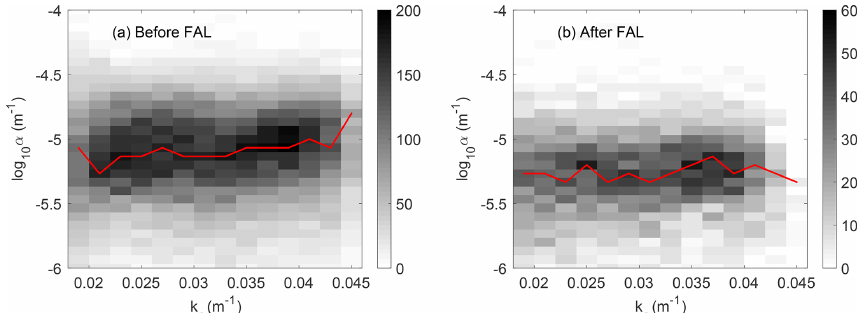
Figure 3. Smoothed two-dimensional histograms of wave number k r and the apparent attenuation α (a) before the FAL and (b) after the FAL. The α domain is equally divided into 30 bins in the log scale from 10 − 6 to 10 − 4 m − 1 . The k r domain is divided from 0.011 to 0.045m − 1 with an increment of 0.002m − 1 . The gray scale indicates the occurrence of α in each α – k r bin from the selected pairs. The red curve indicates the highest occurrence of α against k r